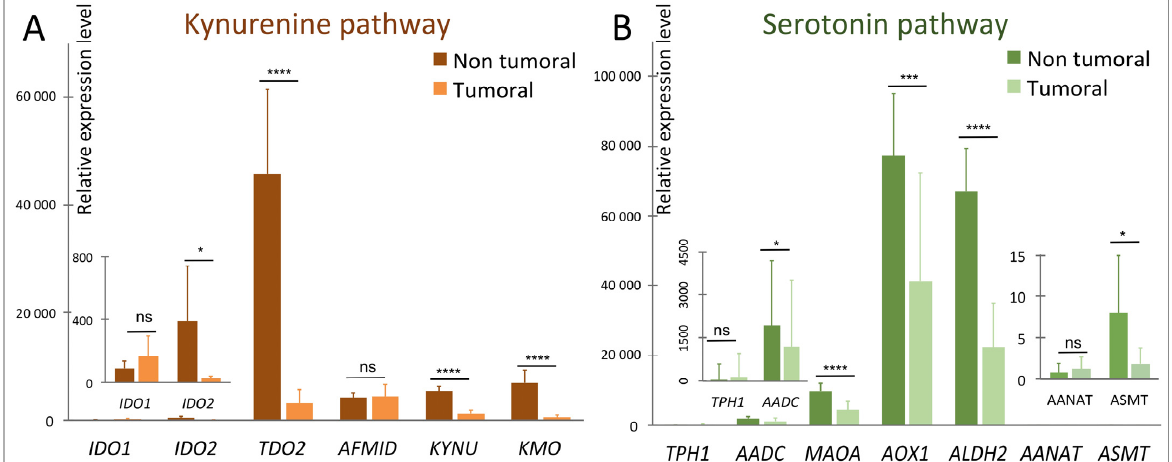
Figure 2. Variation of expression of some of the genes of the kynurenine ( A ) and serotonin ( B ) pathways in HB. See legend to Figure 1 for the abbreviations. AANAT and ASMT , coding both for melatonin-synthesizing enzymes, are barely detectable in both non-tumor and tumor samples while TPH1 expression is increased in tumor samples. In HB, the 5-HT pathway would be reduced to 5-HTP production readdressing the question of the balance between KYN and 5-HT pathways in these tumors. (ns, not significant; *,1 × 10 − 2 < p < 5 × 10 − 2 ; ***, 1 × 10 − 4 < p < 1 × 10 − 3 ; **** p < 1 × 10 − 4 ).